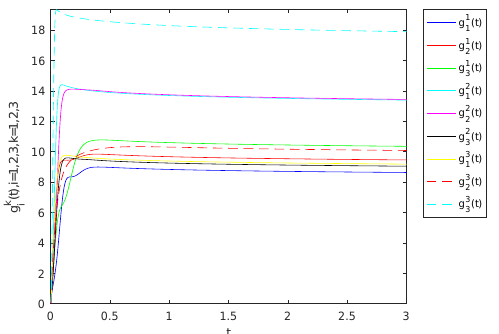
( κ ) ( t ) under Controller (4). ı